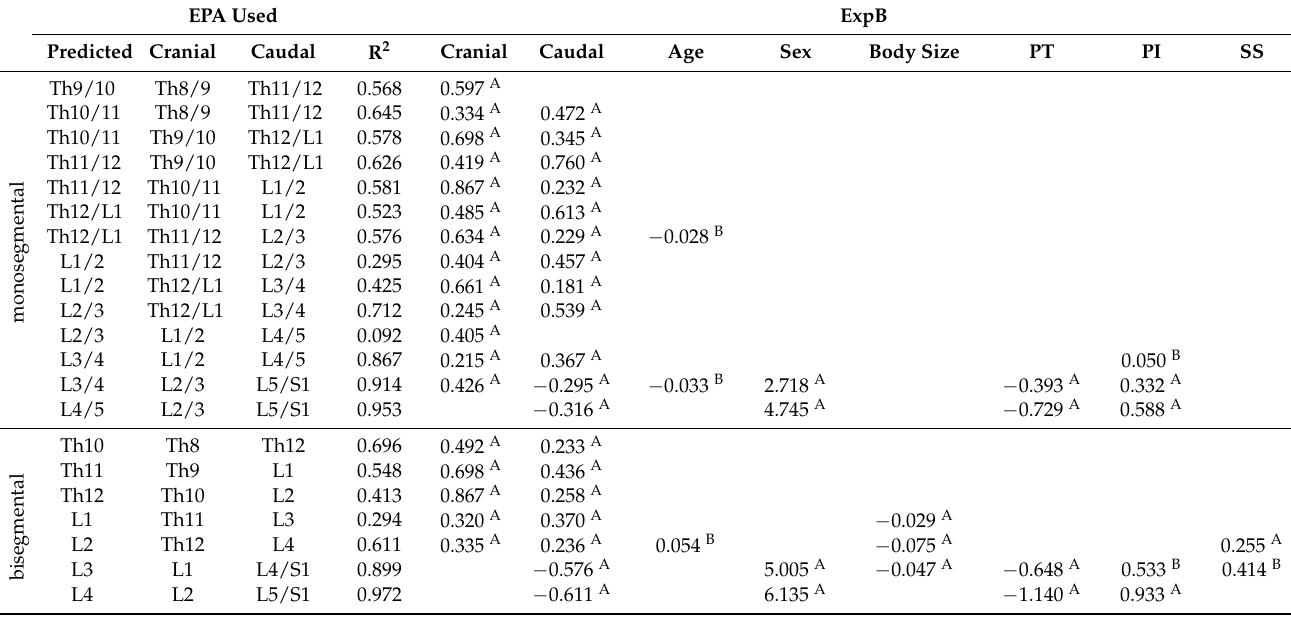
Table 2. Results of the linear regression model for the prediction of mono- and bisegmental endplate angles (mEPA, bEPA). The explained variance (R 2 ) and the significant coefficients (ExpB) for the parameters used are given. Sex was coded as 1 for men and 2 for